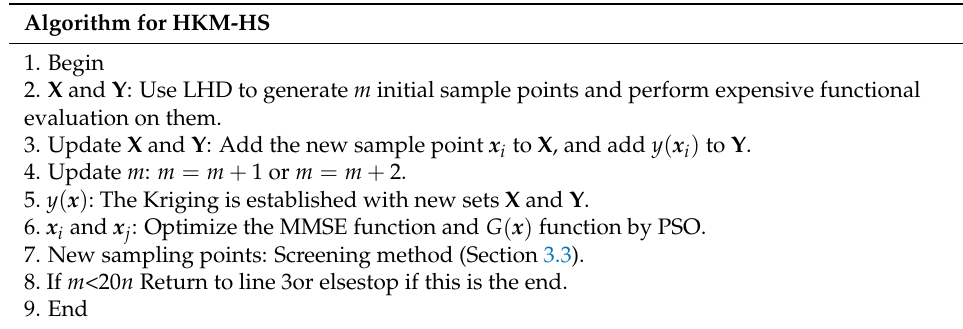
Table 3. The pseudocode of